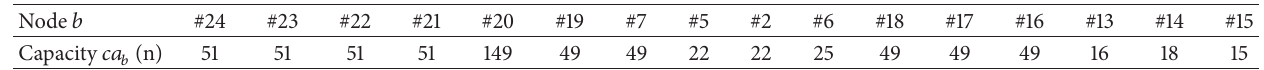
Figure 8: Allocate environmental costs of retrofit work. Table 2: Capacity of